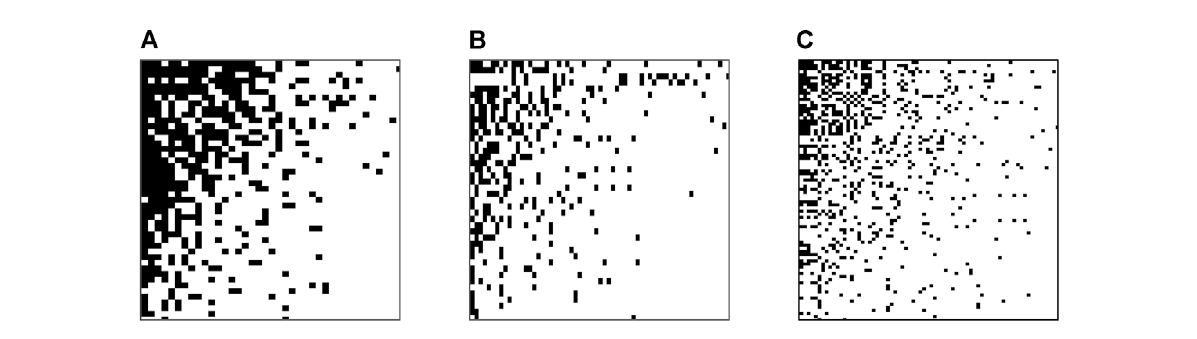
FIGURE 5 Packed nestedness showingdistributionpatterns of fi sh assemblages in (A) upperbasin and (B) lower basinand (C) upperandlower basin using NODF metrics to overlap and decrease fi lls with the CE null